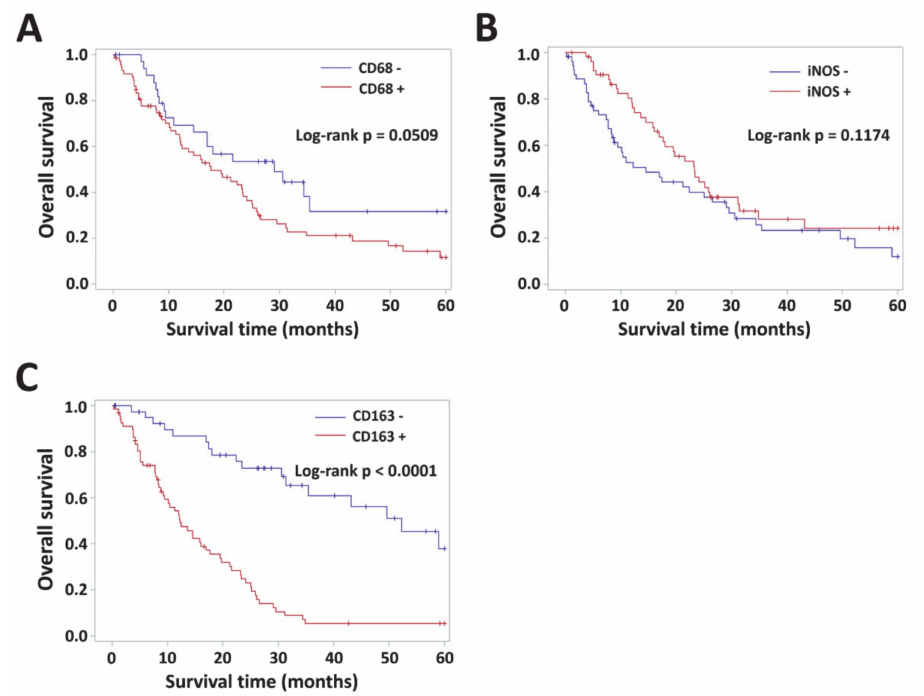
Figure A1. Kaplan–Meier curves for glioma patients with di ff erent levels of TAM biomarkers. Survival curves in patients that had tumors with positive CD68 ( A ), iNOS ( B ), and CD163 ( C ) were plotted. p < 0.05 was considered statistically